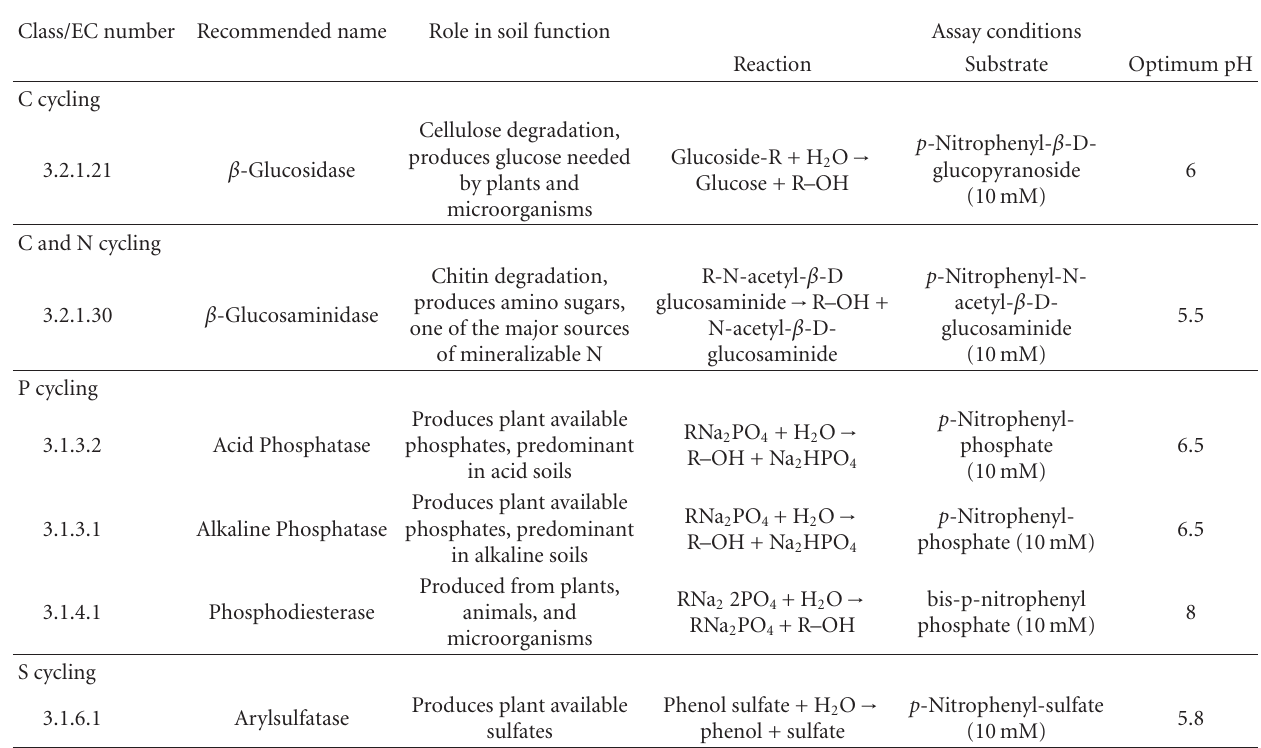
Table 2: Conditions for assay of soil enzyme activities and their role in soil biogeochemical